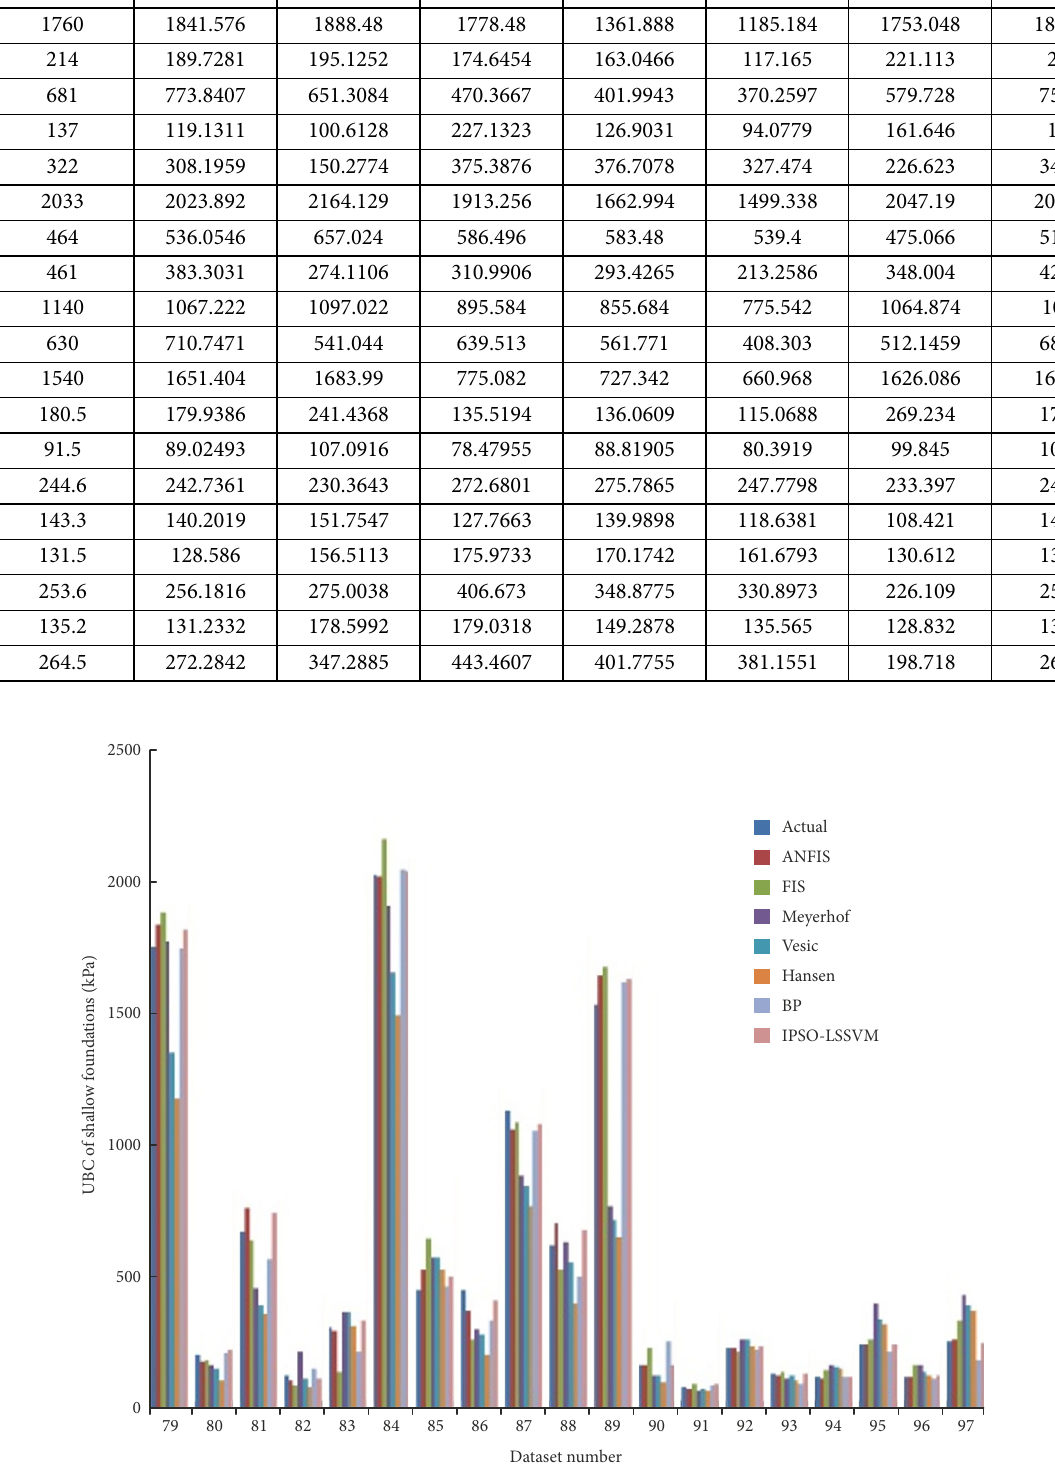
Figure 5. Comparison of the UBC of shallow foundations among all the models